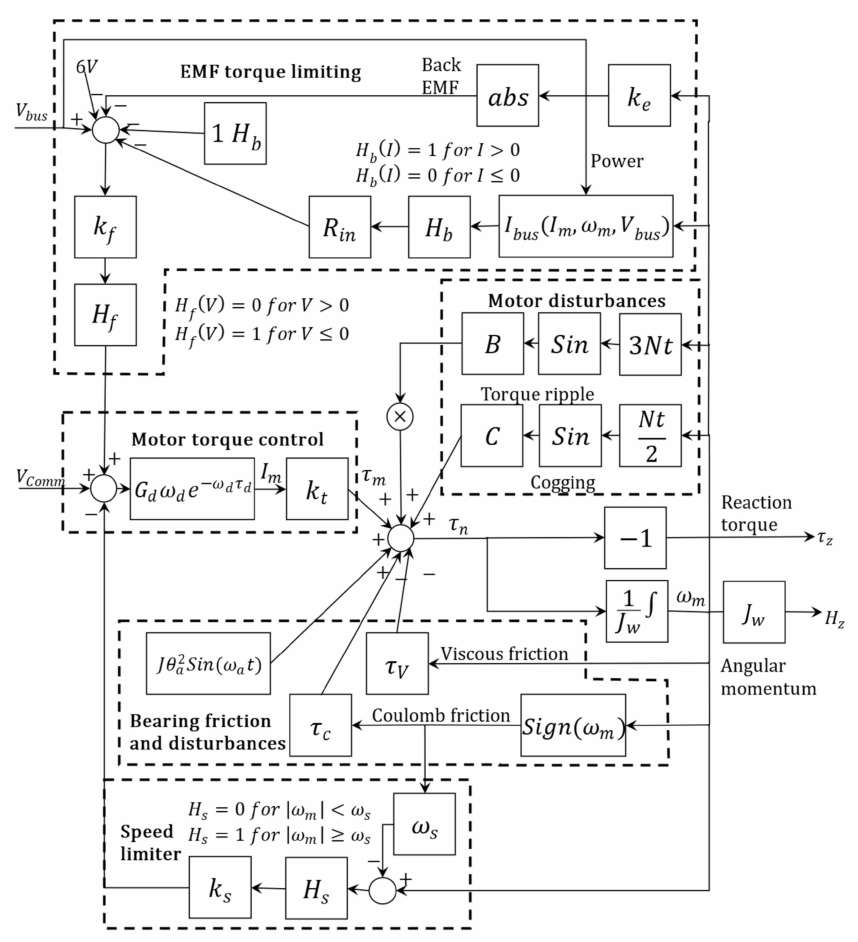
Figure 2. Bialke’s ITHACO Type-A reaction wheel model